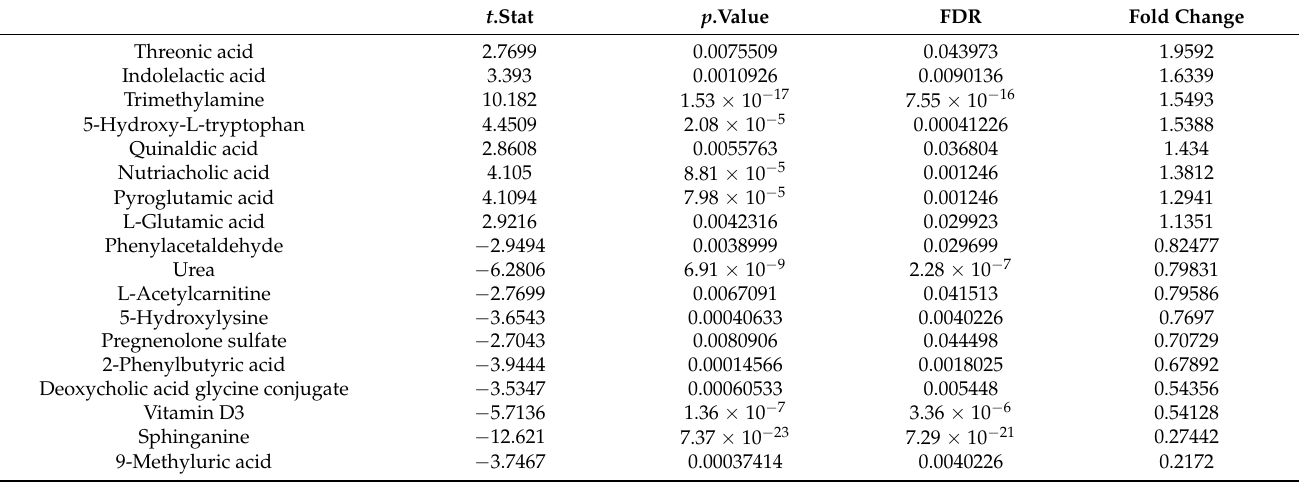
Figure 3. Volcano plot of the prediabetic MetS group and the controls. The t -test identified 18 metabolites as significantly different between the normoglycemic MetS and prediabetic MetS groups (upregulated 8 vs. 10 downregulated) (Table 4). Specifically, threonic acid, indolelactic acid, trimethylamine, and 5-hydroxy L-tryptophan were highly upregulated in the prediabetic MetS group compared to those in the normoglycemic MetS group (Figure 4). In contrast, 9-methyluric acid, sphinganine, vitamin D3, and deoxycholic acid glycine conjugate were highly downregulated in the prediabetic MetS group compared to those in the normoglycemic MetS, as indicated in the volcano plot (Figure 4). Table 4. Statically significant metabolites among the prediabetic MetS and the normoglycemic MetS groups. t